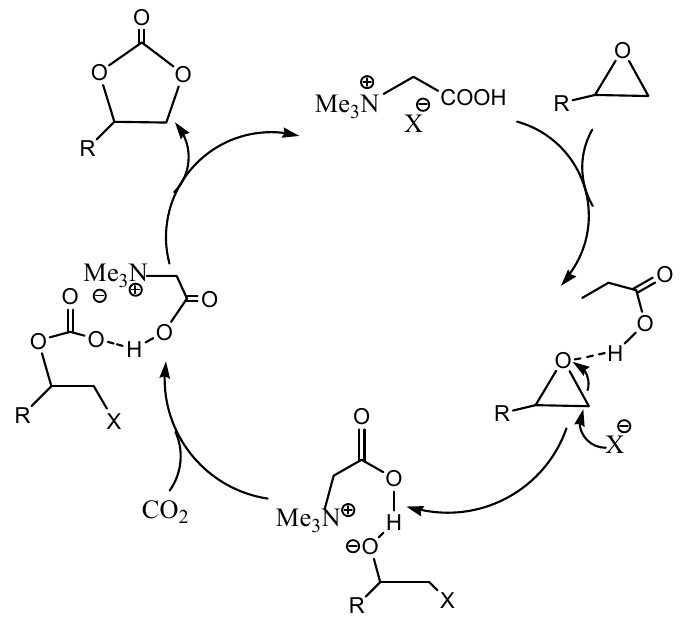
Scheme 6. The plausible cycloaddition reaction mechanism for epoxide ring opening with CO 2 by betaine (HBetX) catalysts [11].